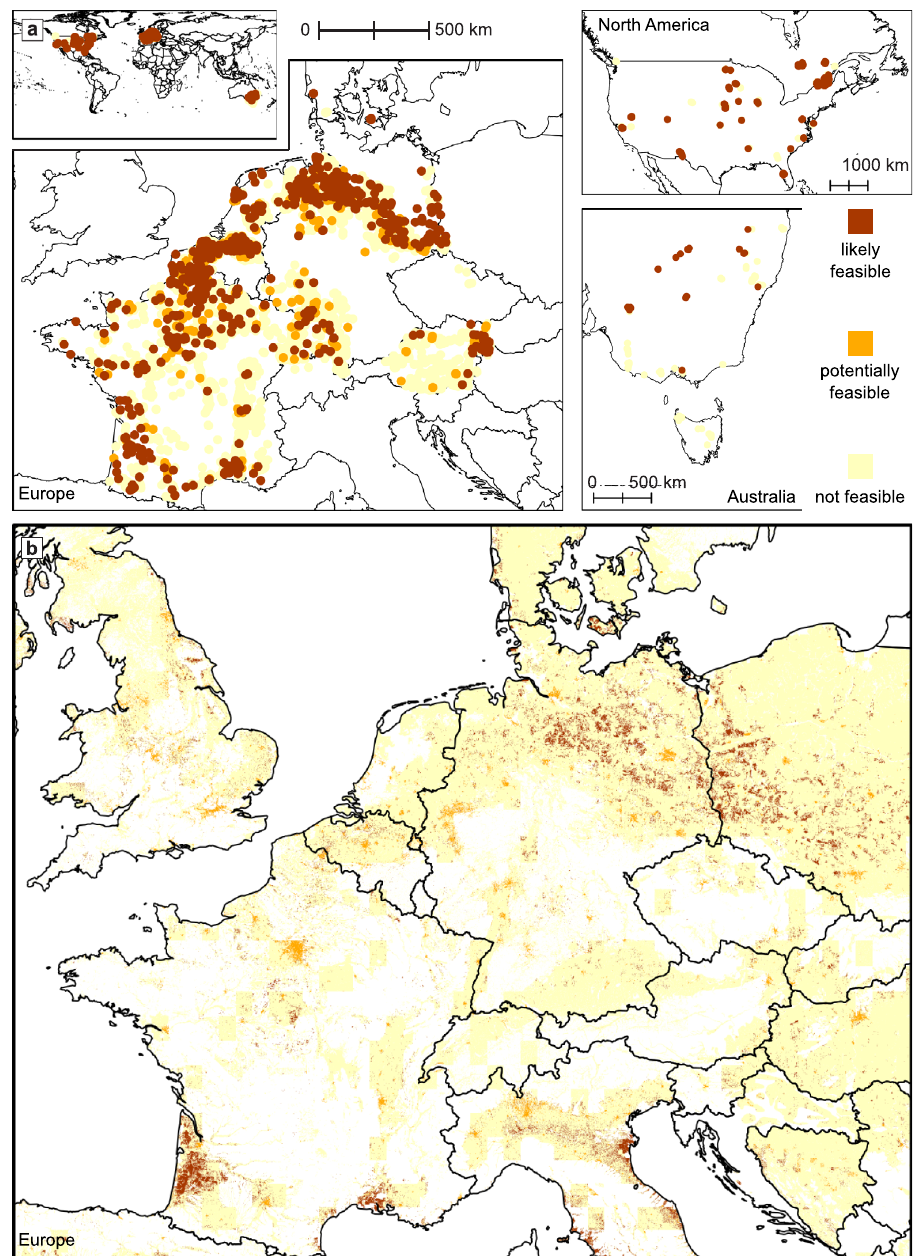
Fig. 5 Feasibility of subsurface heat recycling for our recycled scenario. Please note: for all parts of this fi gure only locations with unconsolidated sediments are shown, or rather classi fi ed. a Map displaying the feasibility of recycling the annual heat input. b Results of the random forest classi fi cation. A zoomable version of these maps is available from